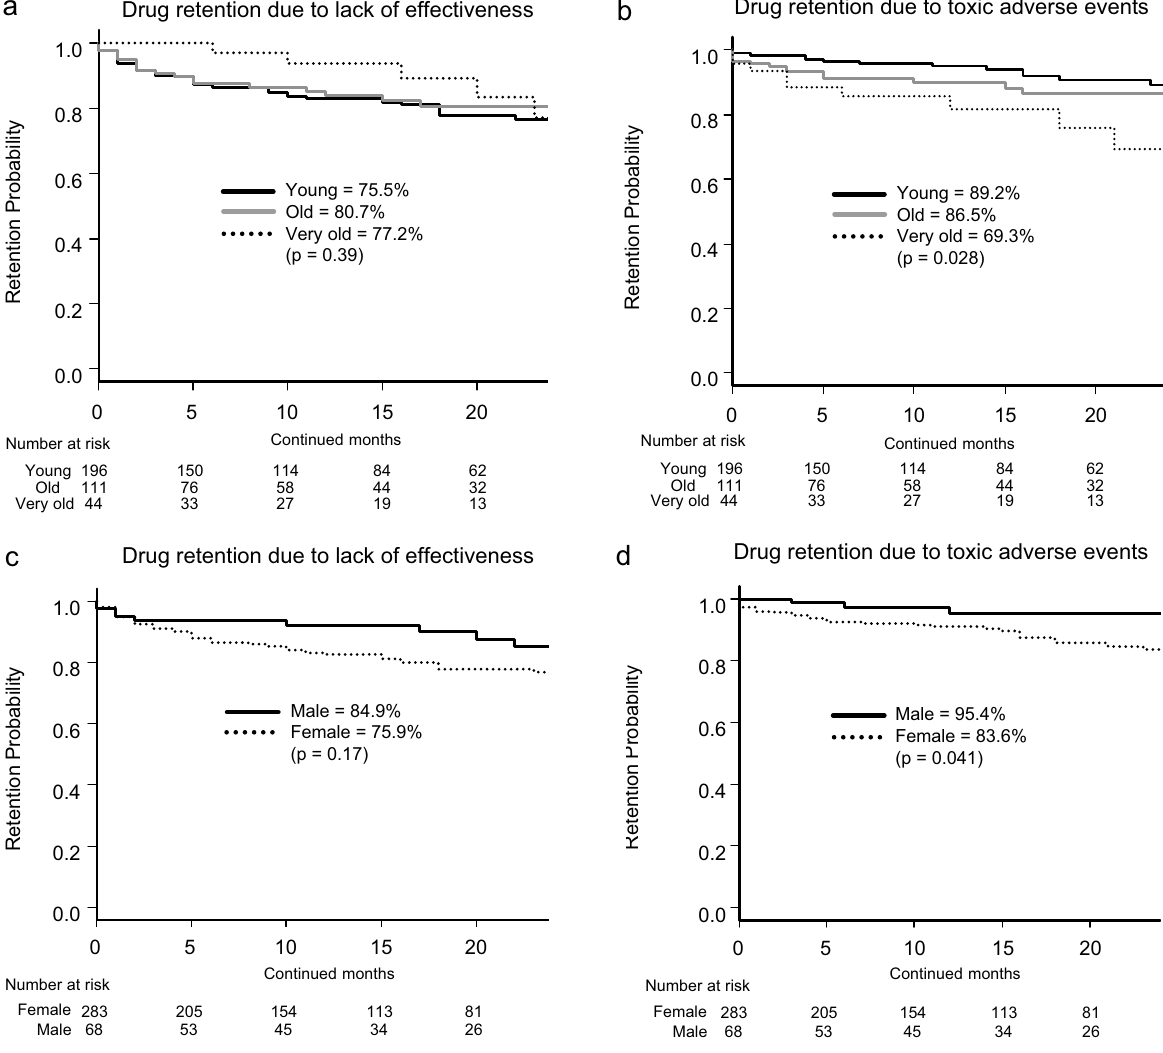
Figure 1. Adjusted drug retention by age and sex. Adjusted drug retention between young (< 65 years), aged (65–74 years), and very old (≥ 75 years) groups, due to ( a ) lack of effectiveness and ( b ) toxic adverse events, and adjusted drug retention between male and female, due to ( c ) lack of effectiveness and ( d ) toxic adverse